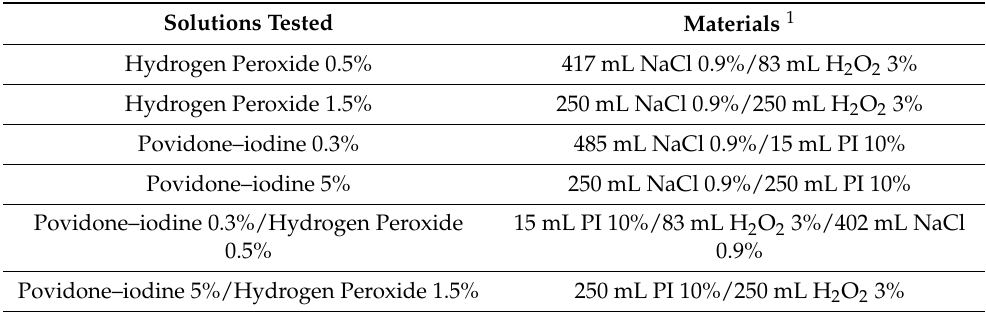
Table 1. Antiseptic